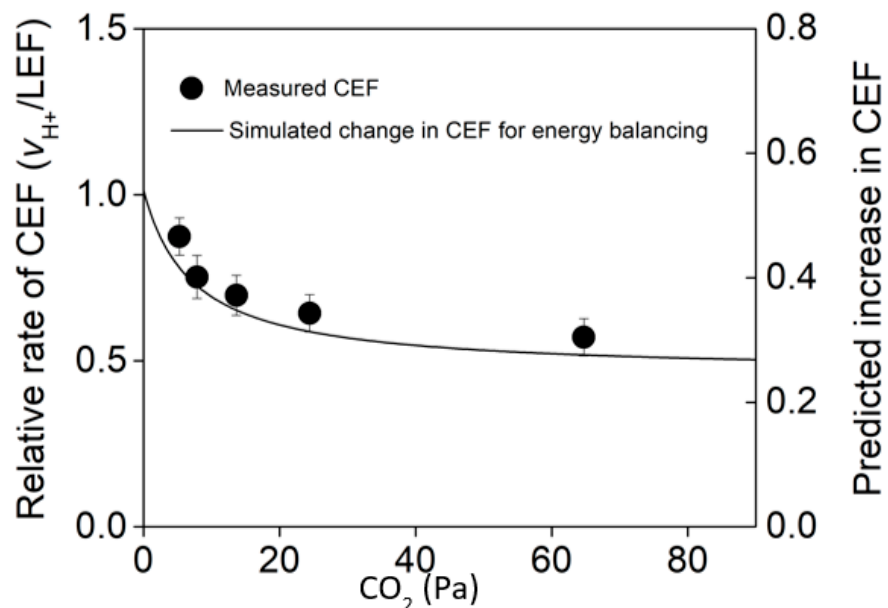
Figure 3. Comparison of the measured relative rate of cyclic electron flux (CEF: circle symbols) to the predicted change in CEF required to match ATP/NADPH supply with demand across CO 2 concentration (line). Shown are n = 3–4 ± SE. This data is a replotted subset of measurements from Walker et al. (2014) [72].